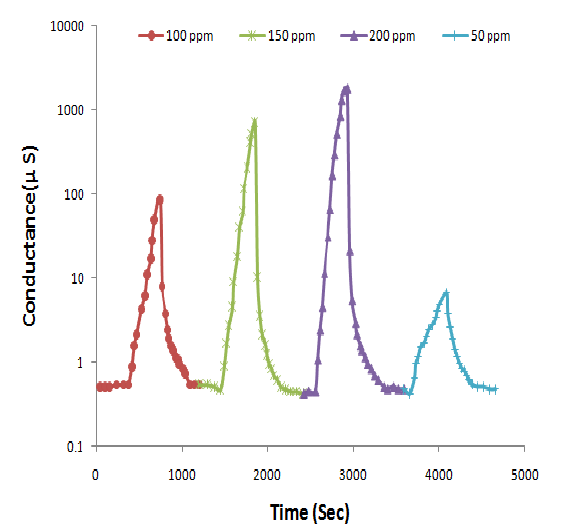
Fig.6: The conductance of ZnO gas sensor (annealed at 450 o C for 4h)under different concentration of H gas at operation 2 temperature 350 o C